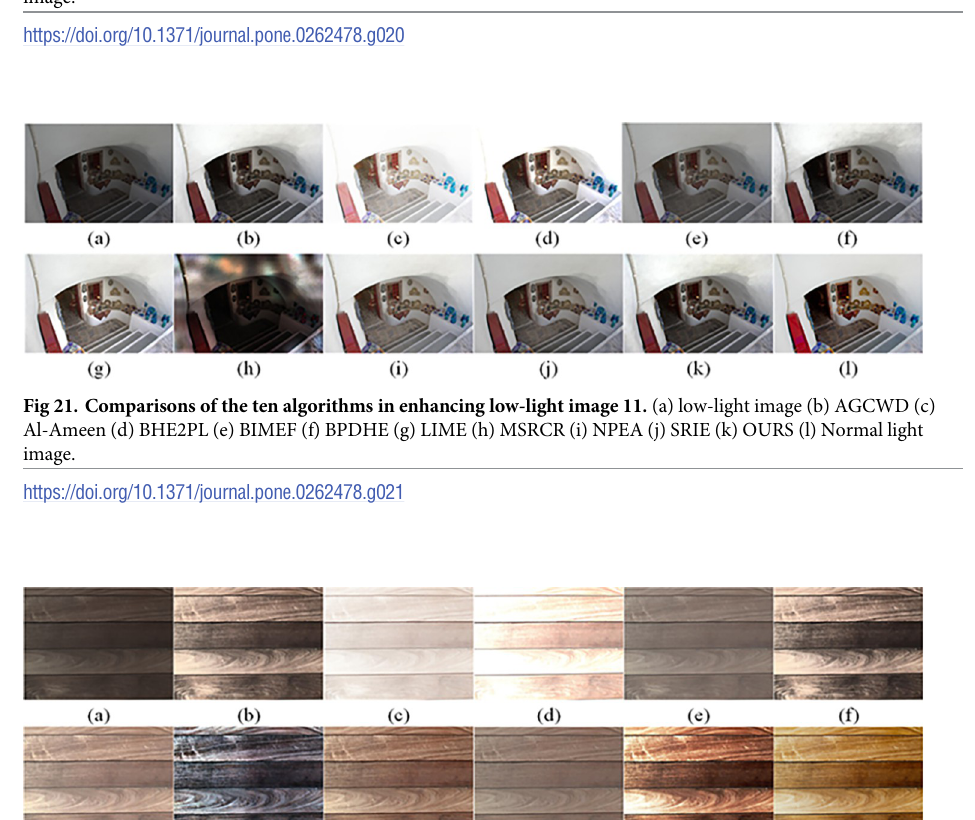
Fig 20. Comparisons of the ten algorithms in enhancing low-light image 10. (a) low-light image (b) AGCWD (c) Al-Ameen (d) BHE2PL (e) BIMEF (f) BPDHE (g) LIME (h) MSRCR (i) NPEA (j) SRIE (k) OURS (l) Normal light image.